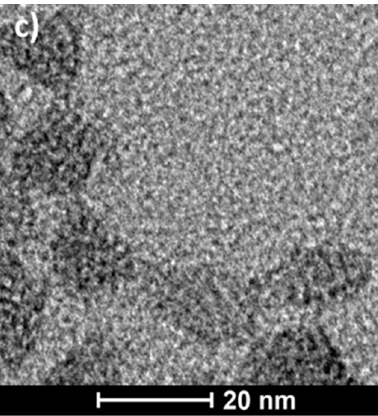
Figure 2. Cryo-TEM micrographs of PS-b-PGL particles formed in dioxane at concentrations 2 mg/mL ( a ) PS- b -PGL(2), ( b ) PS- b -PGL(3), ( c ) PS- b -PGL(4).